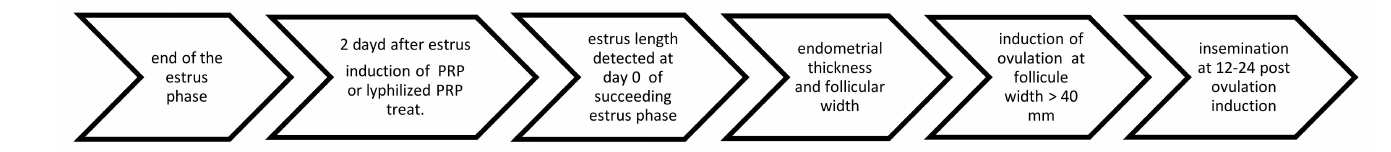
Figure 1. Diagram showing experimental procedures for the conducted